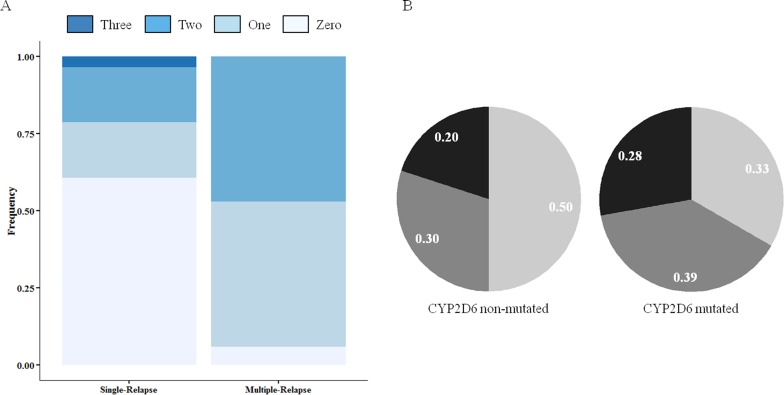
Frequency of CYP2D6 polymorphisms and parasite haplotype among P. vivax-infected patients who had single (n = 28) or multiple (n = 18) episodes of relapse.(A) The number of CYP2D6 polymorphisms is represented by the different intensity of color as specified in the legend. A simple logistic regression model shows a significant relationship between the mutant status for CYP2D6 and the increased number of relapses (OR, 12.4; 95% CI, 2.80–88.57; P = .003). (B) Frequency of parasite haplotype in patients without or with CYP2D6 mutation. Parasites were classified according to the number of markers containing identical alleles: identical in black (parasites showing all 10 identical markers); related in gray (8 to 9 identical markers); and heterologous in light gray (less than 8 identical markers).